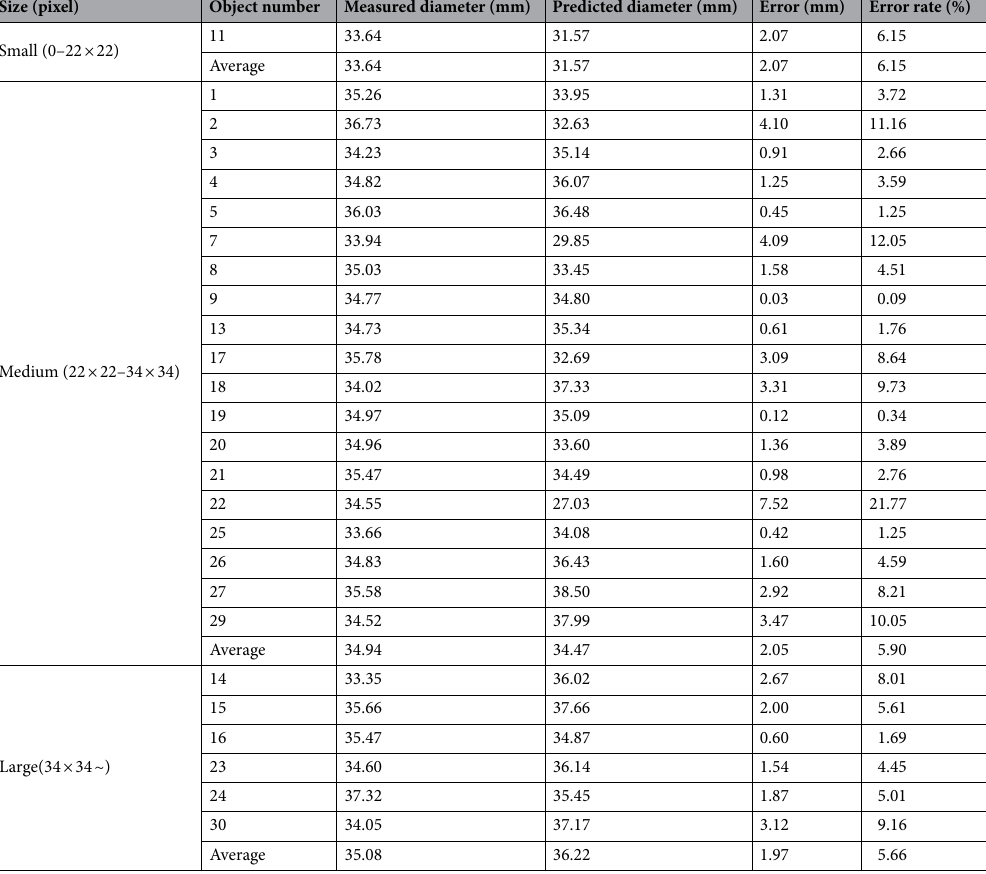
Table 3. Results of applying growth evaluation algorithm to an indoor